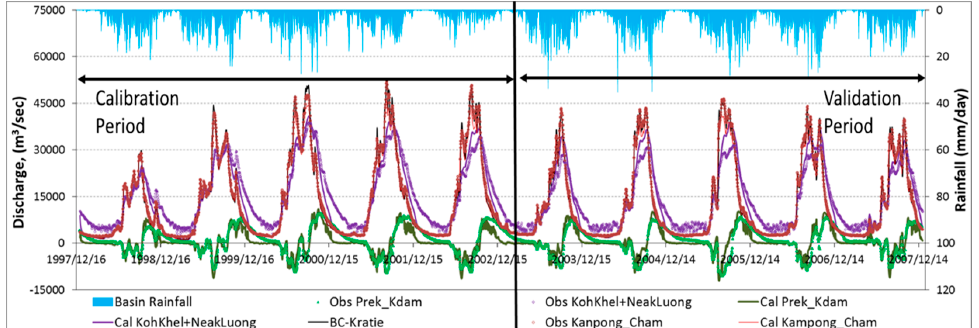
Figure 4. Comparison of observed and simulated discharges at the river gauging stations located in the LMB. Table 1. Performance indicators for RRI simulated river runoff of selected gauging stations in the LMB. Performance Indicators